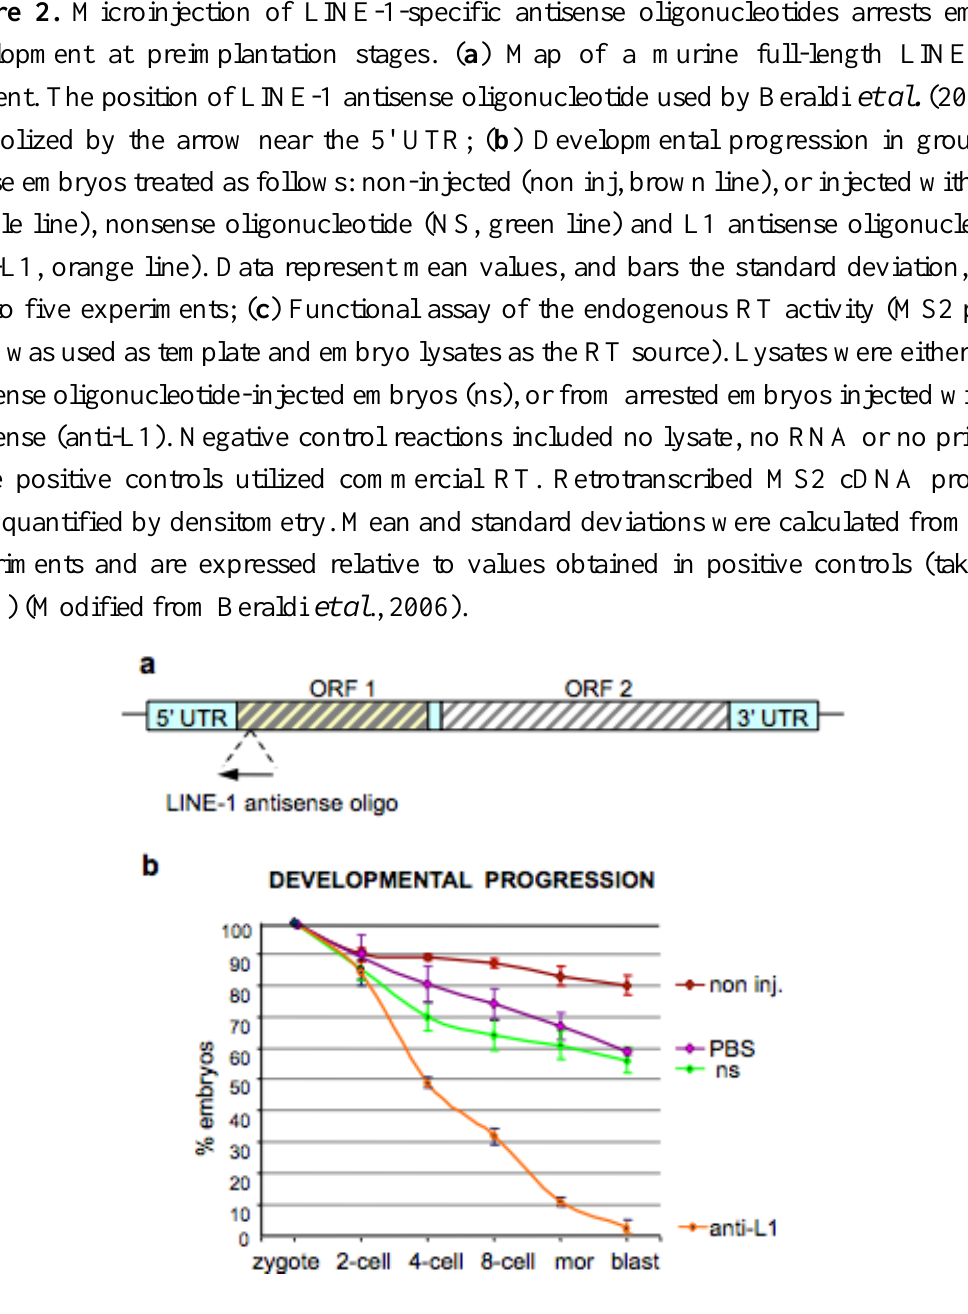
Figure 2. Microinjection of LINE-1-specific antisense oligonucleotides arrests